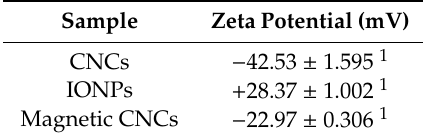
Table 1. Zeta potentials of cellulose nanocrystals (CNCs), iron oxide nanoparticles (IONPs) and magnetic